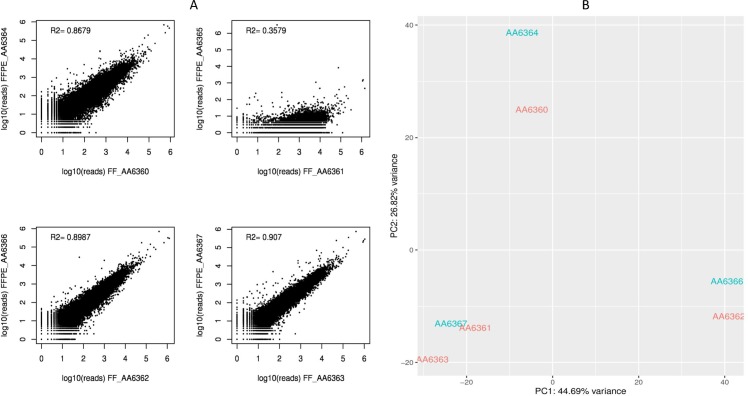
Comparison of gene expression between FF and FFPE samples.(A) Correlation plots of gene expression in FF-FFPE pairs. In general, the correlation was high (R2~0.9), with the exception of the FF_AA6361-FFPE_AA6365 pair, where the FFPE sample was highly degraded. Higher variability was observed for more degraded samples. (B) Results of the principal component analysis. FF-FFPE pairs clustered together. The most degraded sample (FFPE_AA6365) was not included in the plot.